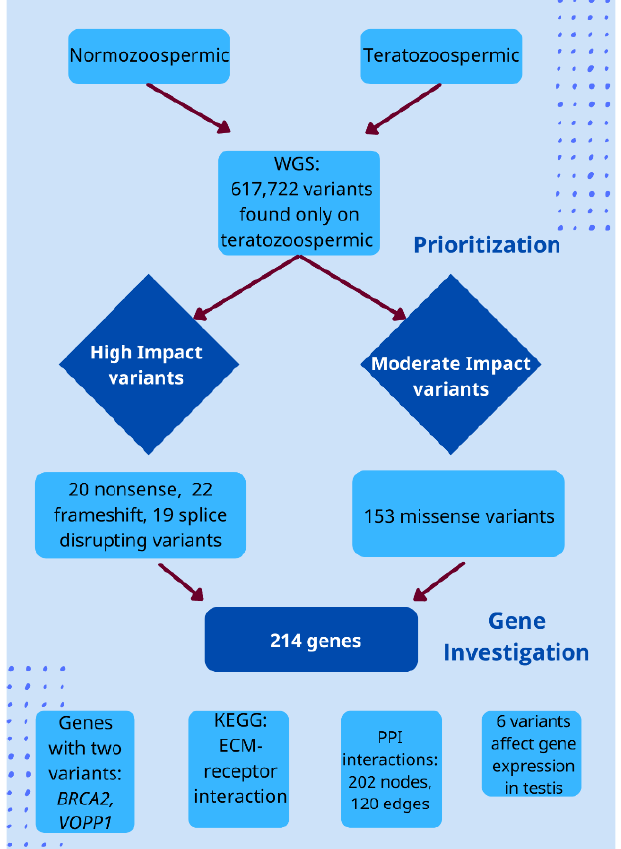
Figure 6. The main results of the present study. As presented, after WGS, 617,722 variants were identified only in teratozoospermic individuals. These were further prioritized to identify those with the greatest possibility to contribute to the pathogenic phenotype. Thus, 20 nonsense, 22 frameshift, and 19 splice-disrupting variants were characterized as high impact variants, being the most likely to affect protein function. A total of 153 missense variants were also identified. Further investigation of the genes on which these were found revealed that two genes carry more than one mutation in teratozoospermic individuals, and most genes play a role in the extracellular matrix–receptor interaction. In addition, many protein interactions were identified and some of the variants can affect gene.